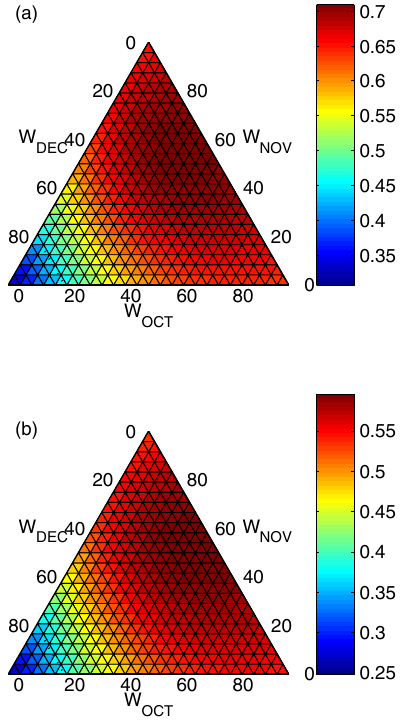
Figure 5. The impact of monthly weighting factors in Eq. (4) on the sampled correlation between (a) d θ PM / d t and P − Q − E T and (b) d θ PM / d t and d S GR / d t